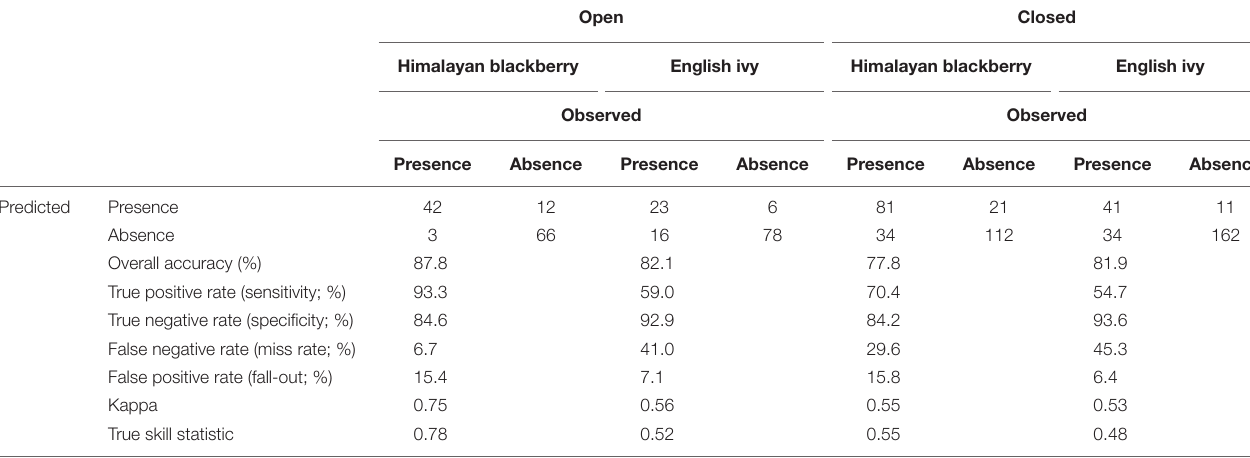
TABLE 3 | Accuracy of the random forest models for detecting Himalayan blackberry ( Rubus armeniacus ) and English ivy ( Hedera helix ) in open areas and areas with closed canopies in Surrey, BC, Canada.